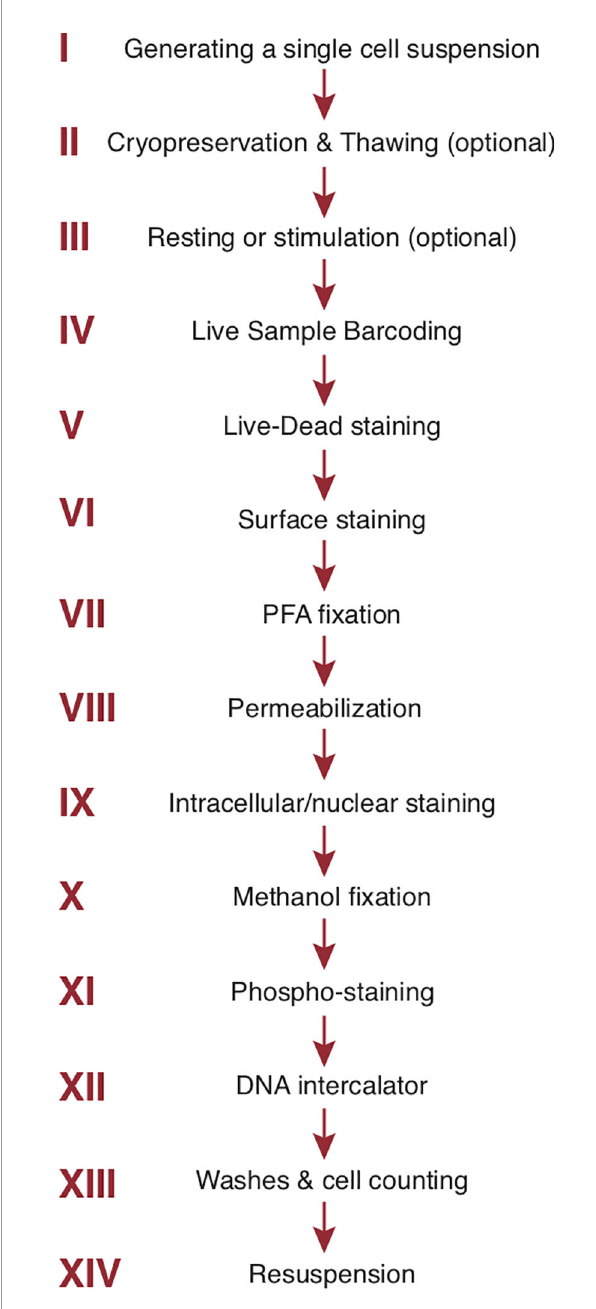
FIGURE 3 | Step-by-step sample preparation. Representative sample preparation protocol. The order of individual steps may vary depending upon the experimental design (see text). Sample washes with cell staining buffer separate each step. The fi nal 3 steps are speci fi c to mass cytometry. PFA ,